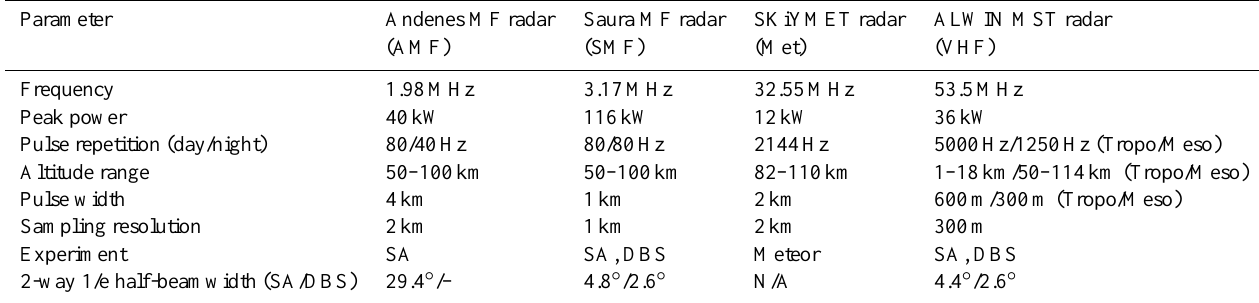
Table 1. Experimental parameters of the radars located at Andenes (69 ◦ N, 16 ◦